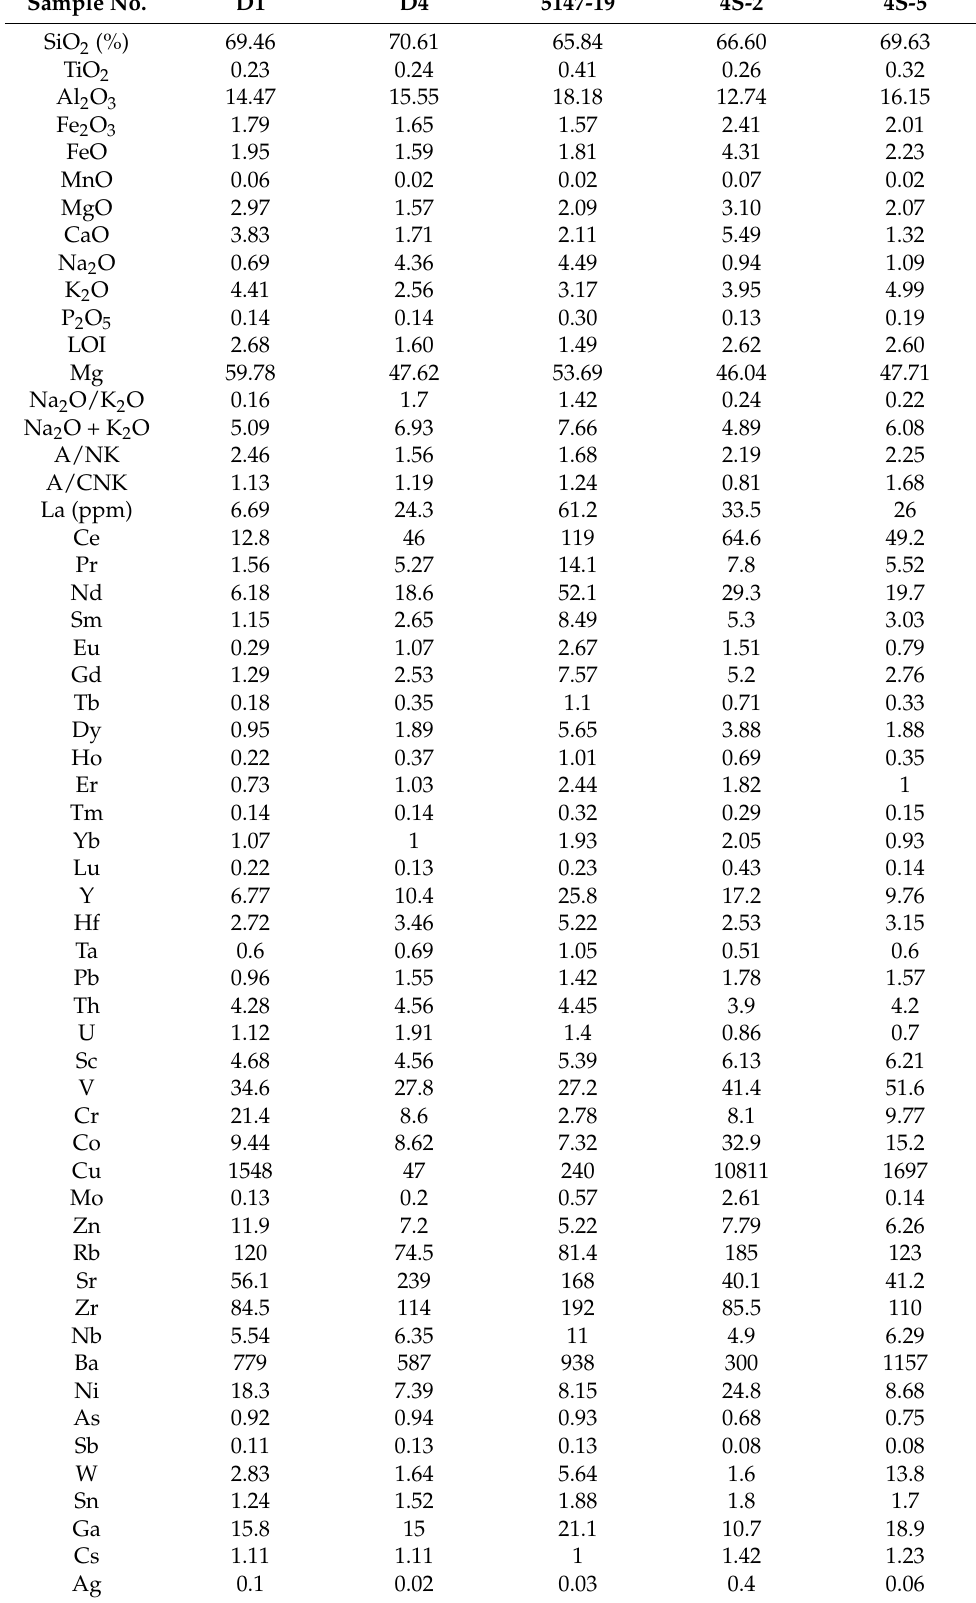
Table 3. Whole rock major and trace element compositions of Tongkuangyu granodiorite porphyry. Sample